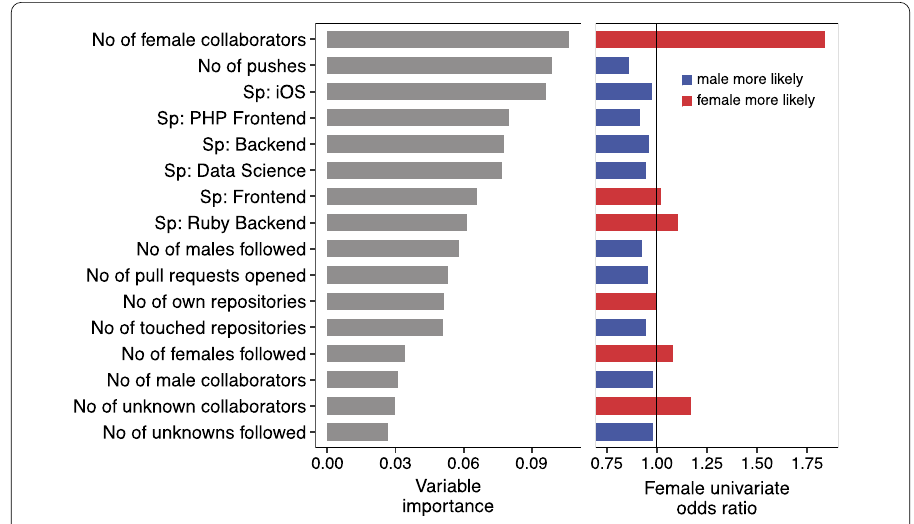
Figure 4 Variable importance. Variable importance in gendered behavior prediction by the Random Forest Prediction and Female univariate Odds Ratios in predicting gender with logistic regression